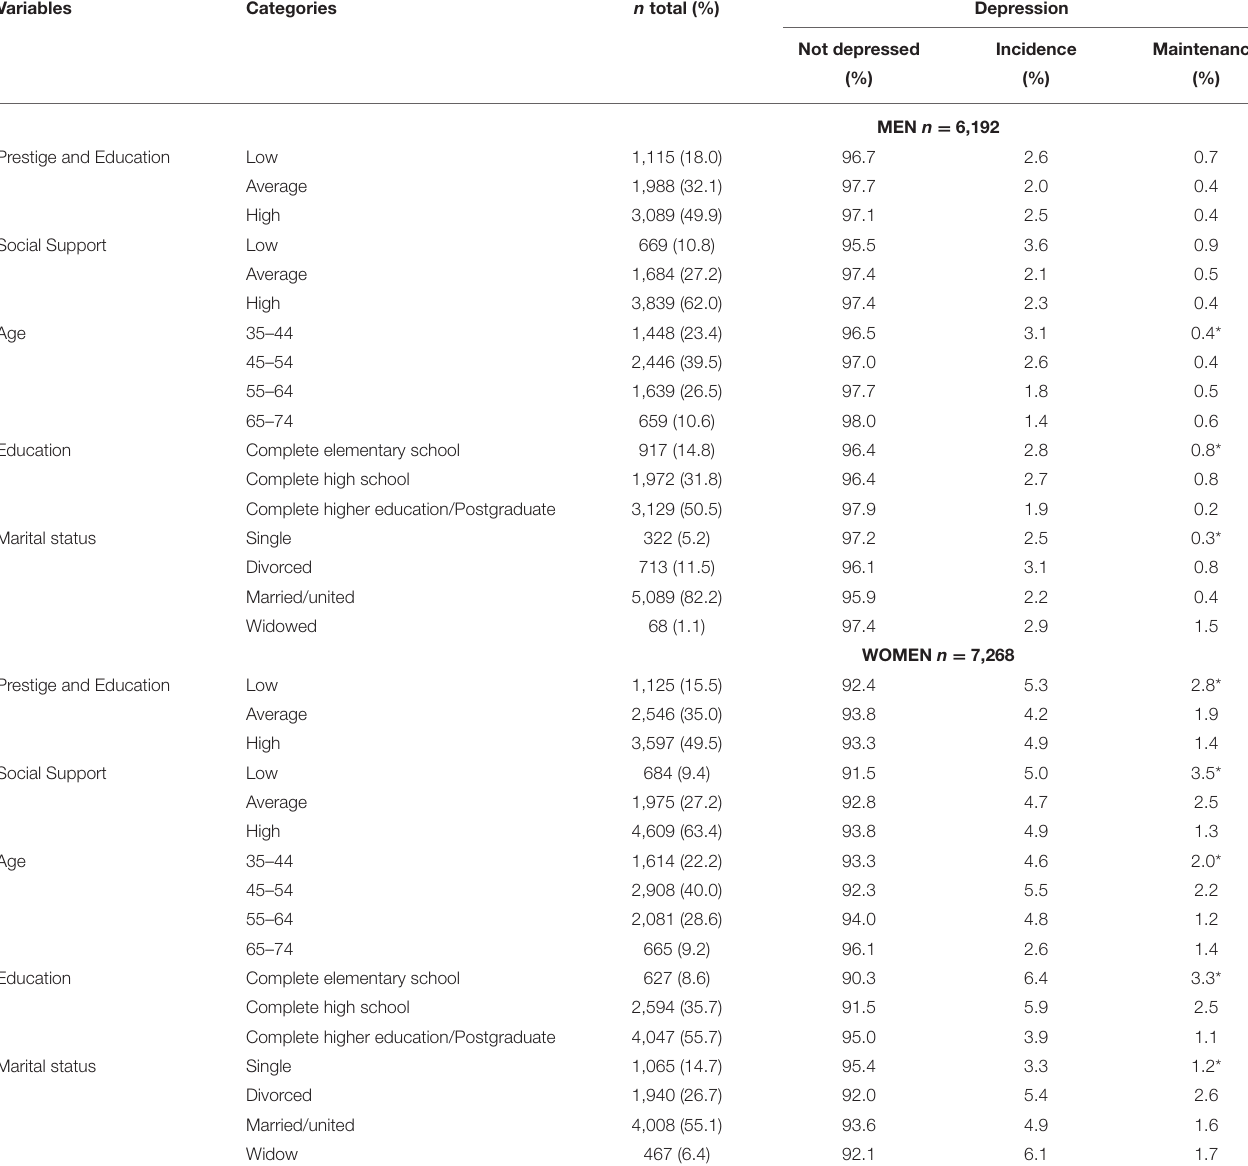
TABLE 1 | Characterization of men and women according to the level of social capital of ELSA-Brasil.